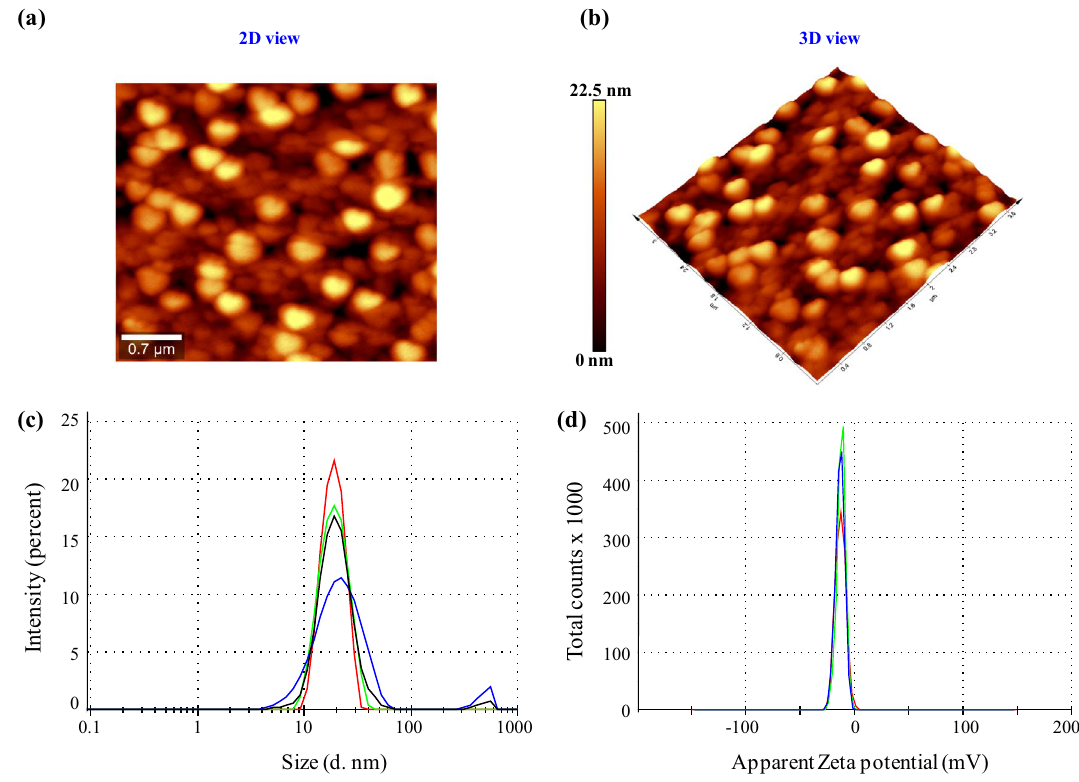
Figure 2. Atomic force microscopy (AFM) results of Phormidium derived CuONPs ( a ) Unfiltered AFM image showing topographical 2D image; ( b ) 3D image. Particle size analysis of CuONPs ( c ) Size distribution through Zeta size analyzer; ( d ) Zeta potential